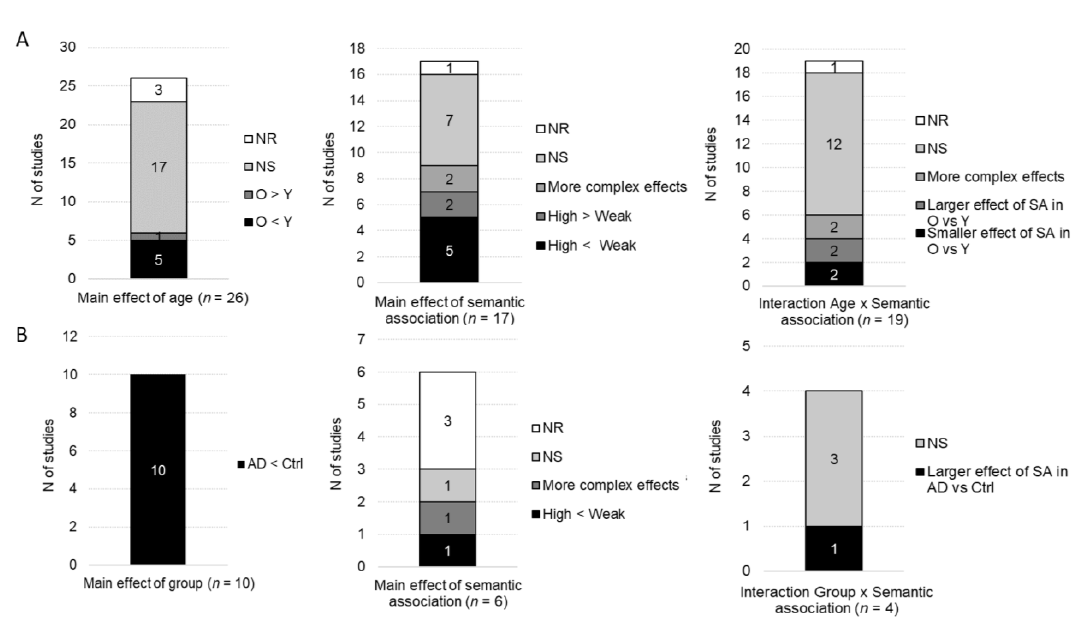
Figure 2. Qualitative results for behavioral accuracy: main effects of age/group, semantic association and the interaction group x semantic association. ( A ) Studies including older and younger groups of participants. ( B ) Studies including Alzheimer’s disease (AD) participants and control groups. N of